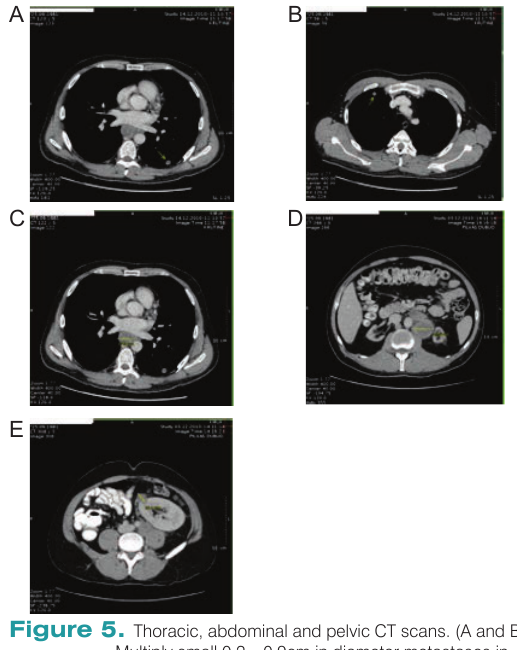
Figure 6. Residual masses of tumor after chemotherapy. (A) Left lung S6 metastasis. (B) No signs of pathological lymph nodes in posterior mediastinum. (C) Pathological paraaor - tic lymph nodes. (D) Metastasis in transplanted